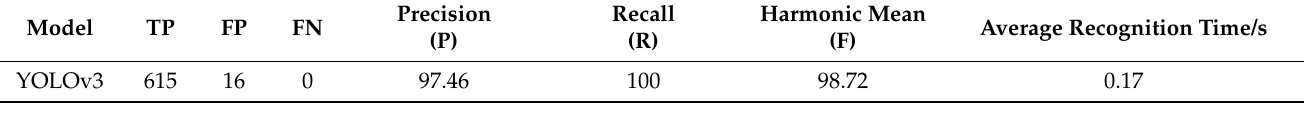
Table 1. Statistics of the detection results.